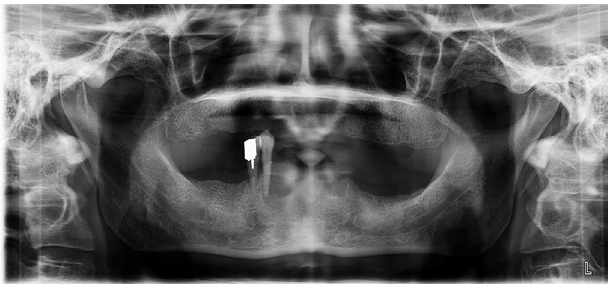
Fig. 2. An orthopantomogram showing signs of osteolysis around the